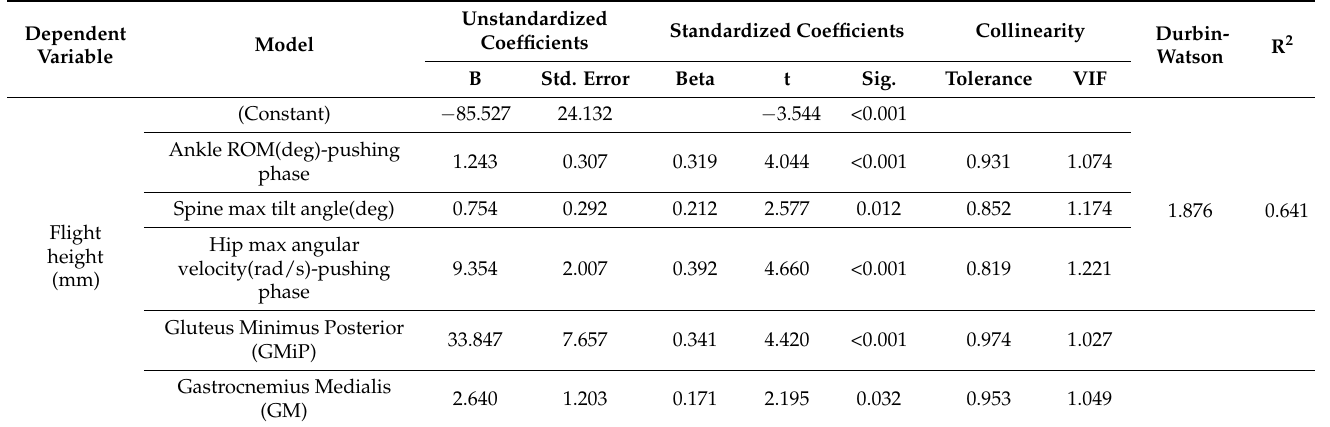
Table 10. Regression analysis of influencing factors of vertical